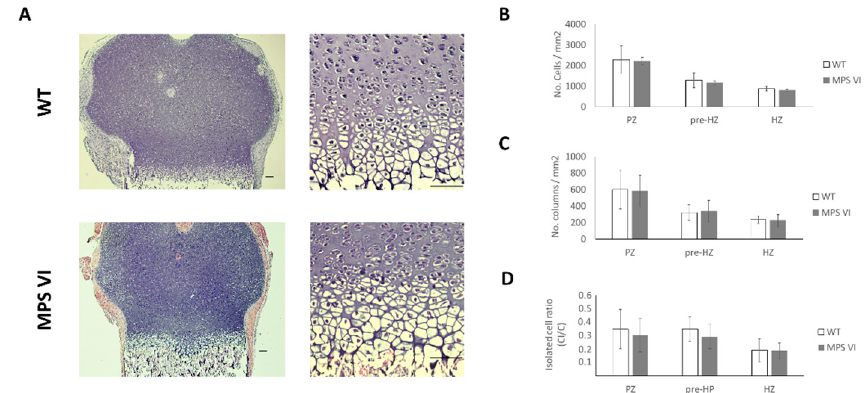
Figure 3. Histological characteristics of growth plates from 4-day-old wild type (WT) and mucopolysaccharidosis type VI (MPS VI) rats. ( A ) Histological sections stained with hematoxylin and eosin images at 4× ( left ) and 20× ( right ) magnification. Scale bars correspond to 100 µm; ( B ) Cell density results per zone (C); ( C ) Column density (CD) results per zone; ( D ) Results for isolated cells ratio per zone. Open and black bars correspond to wild type (WT) and MPS VI rats, respectively. Results are reported per growth plate zone as follows: proliferative (PZ), pre-hypertrophic (pre-HZ), and hypertrophic (HZ) zones ( n = 3 per group).